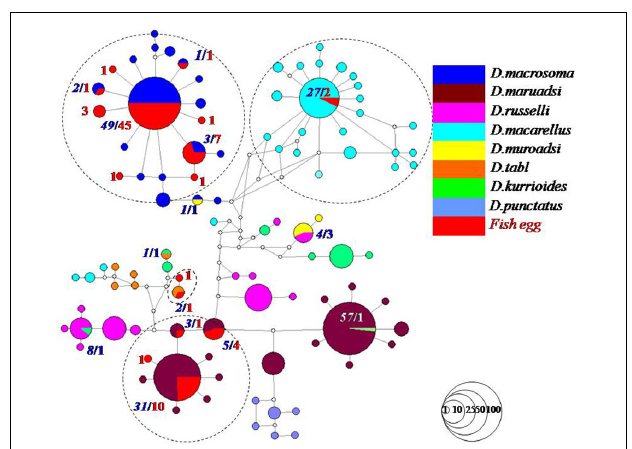
FIGURE 3 | Decapterus spp. egg haplotype network analysis combined with downloaded sequences from NCBI. Red numbers in bold and italic indicated fish egg sequences, and blue and white numbers in bold and italic indicated downloaded fish sequences. Circles represent haplotypes, and each circle is proportional to the number of occurrences of the corresponding haplotype. The dotted circles contained the eggs and the downloaded sequences of four Decapterus fish